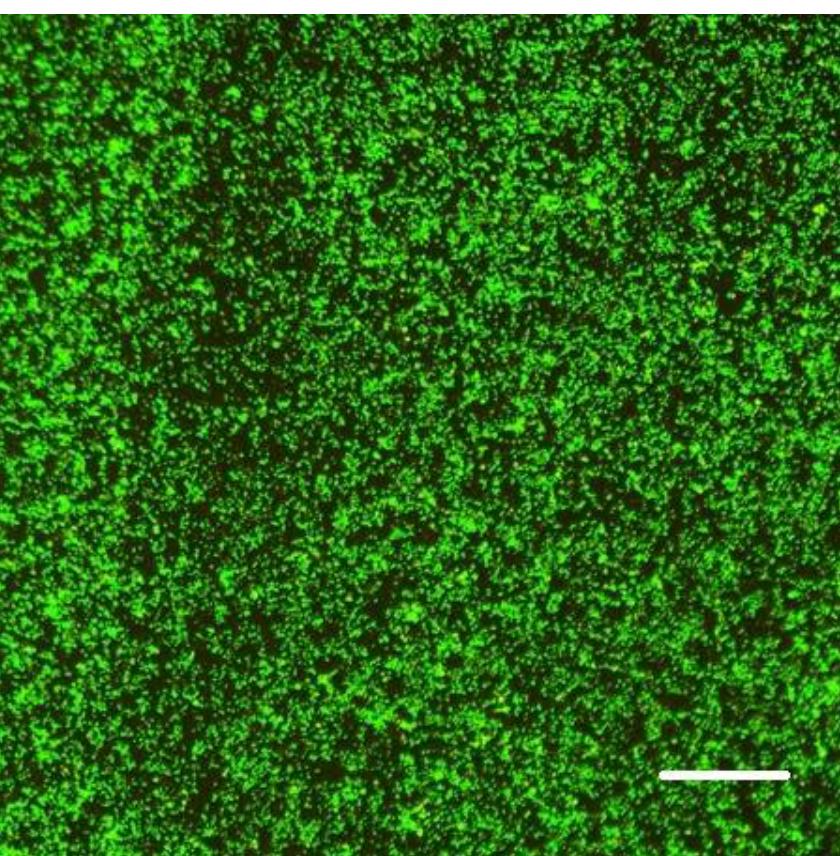
Figure 3. Widefield microscopy view of the S. epidermidis biofilm in the Ibidi flow cell channel. Composite image of green (G) and red (R) fluorescence; exposure G = 80 ms; R = 100 ms) with 20×/0.8NA lens of AxioObserver microscope (scale bar = 100 μm).